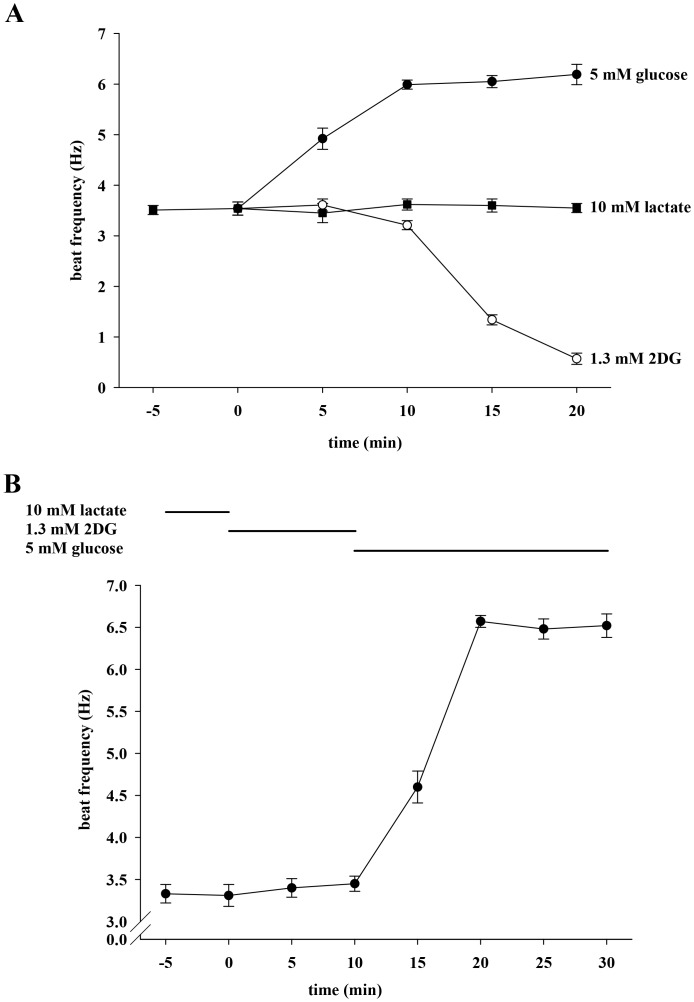
2-deoxy-D-glucose (2DG) cannot mimic the effect of glucose on sperm beat frequency.
A, Sperm were initially perifused with buffer HS containing 10 mM lactate. During subsequent 20 min, perifusion was switched to buffer containing 5 mM glucose (filled circles) or 1.3 mM 2DG (open circles) as energy source. For control measurements, sperm remained in lactate-containing buffer (filled squares). Significant changes were analyzed relating to t  = 0. For clarity, statistical symbols are omitted in some of the following figures but explained in the respective figure legend. At t ≥5 min, values were significantly increased (***p<0.001) during application of glucose as well as at t ≥15 min during application of 2DG. B, Sperm were first perifused with buffer HS containing 10 mM lactate only. As indicated, sperm were then stimulated for 10 min with 1.3 mM 2DG followed by another 20-min treatment with 5 mM glucose. Significance was analyzed relating to t  = 0 min and values were significantly different at t ≥15 min (***p<0.001). Each plot represents mean values±s.e. of 36 cells of 3 animals.